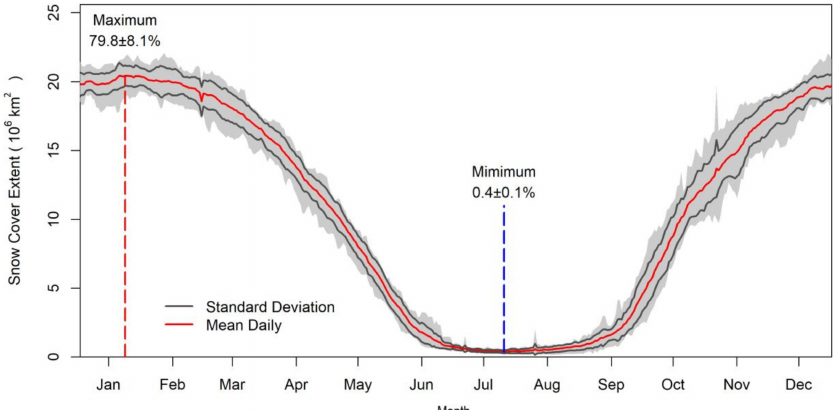
Figure 3. Average daily variation of snow cover extent (SCE) across the study area from 2000 to 2016. The red line represents the average daily value of SCE. The black lines show average daily SCE increases and decreases with one standard deviation, respectively. The grey region indicates the range of SCE of each day. The red dotted line shows the time of average maximum SCE of 27.08 × 10 6 km 2 (79.8% of study area), that is January 7. The blue dotted line shows the time of average minimum SCE of 0.14 × 10 6 km 2 (0.4% of study area), that is July 11.